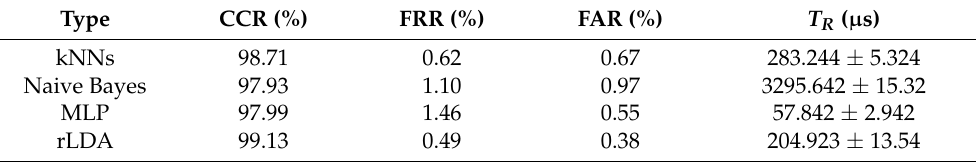
Table 9. Classification results for ensemble of homogeneous classifiers, majority vote.